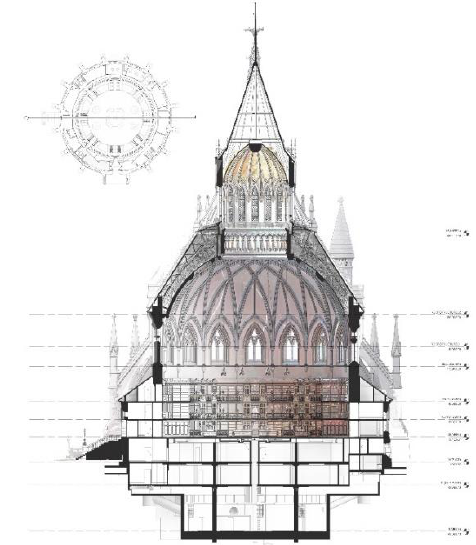
Figure 3. Revit model of the Library of